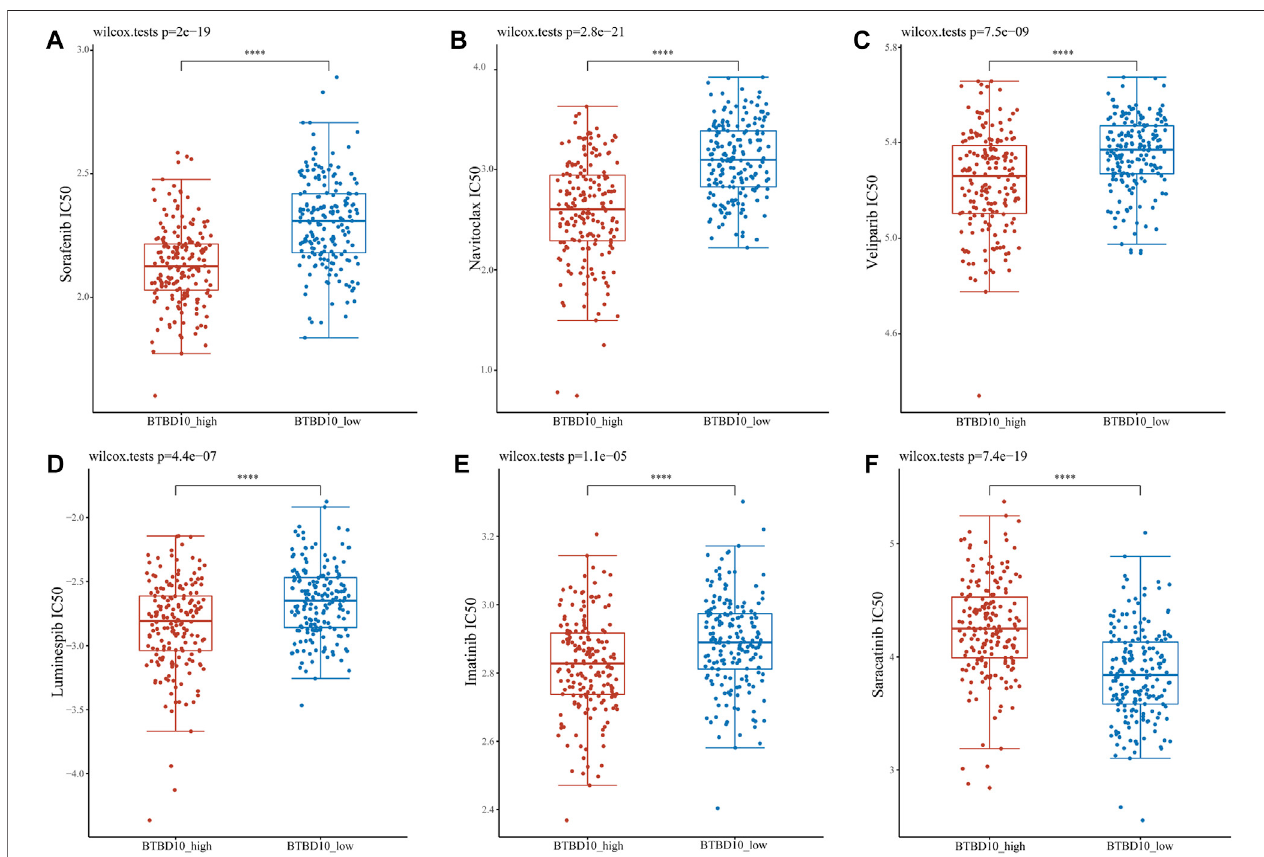
FIGURE 9 | Distribution of IC50 scores of targeted drugs in different BTBD10 expression groups via ACLBI website. (A) Sorafenib (B) Navitoclax (C) Veliparib (D) Luminespib (E) Imatinib (F) Saracatinib.